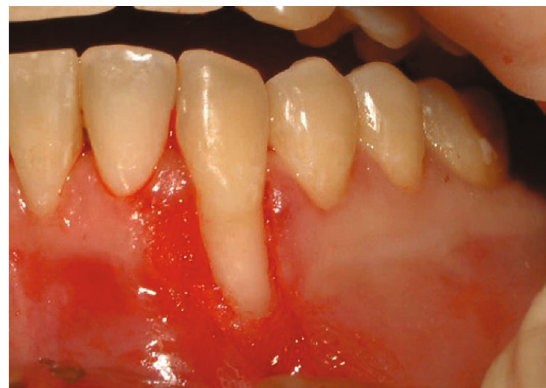
Figure 7: A beveled bleeding area was created mesially in the reception area.